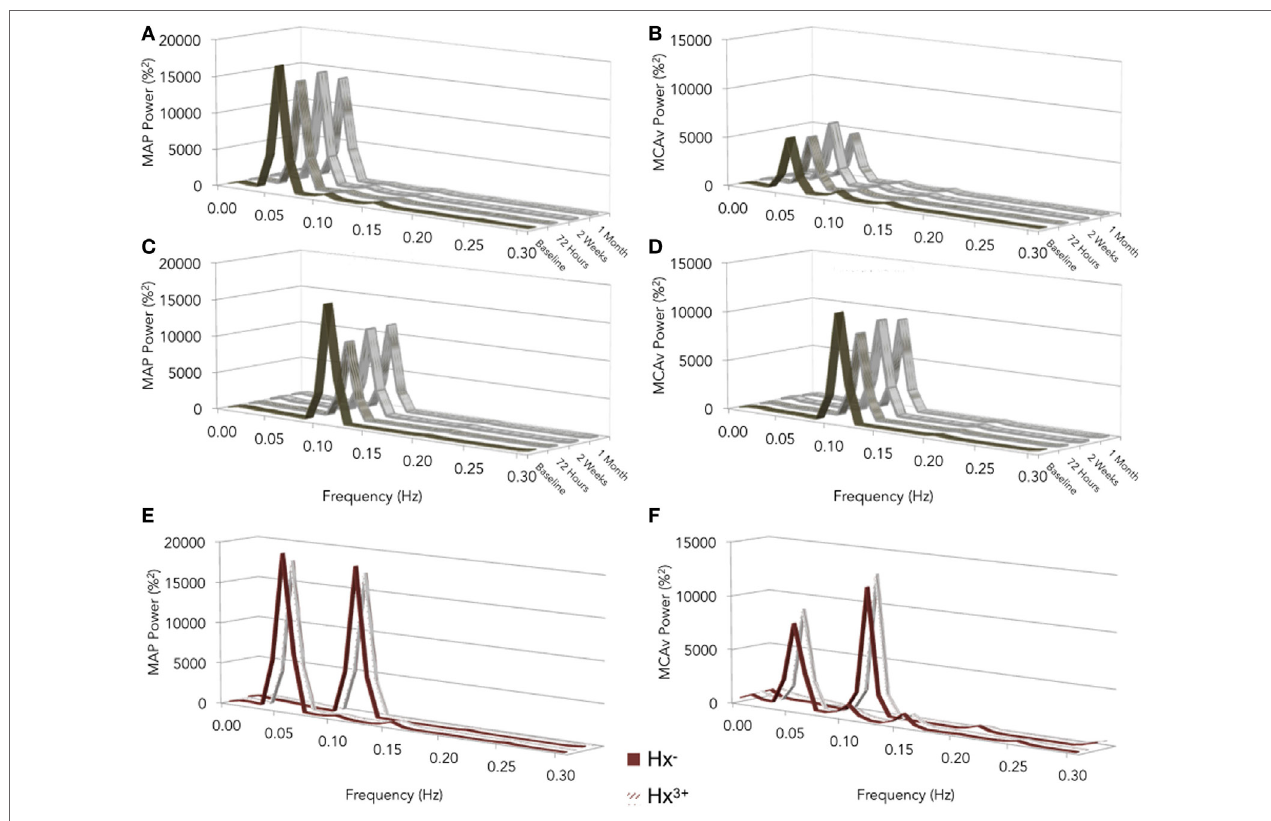
Table 2 | Summary data for transfer function analysis outcomes in the concussed athletes across the four testing sessions. Metric Frequency (hz) concussed athletes ( n = 18) p Preseason 72 h 2 Weeks 1 Month Coherence